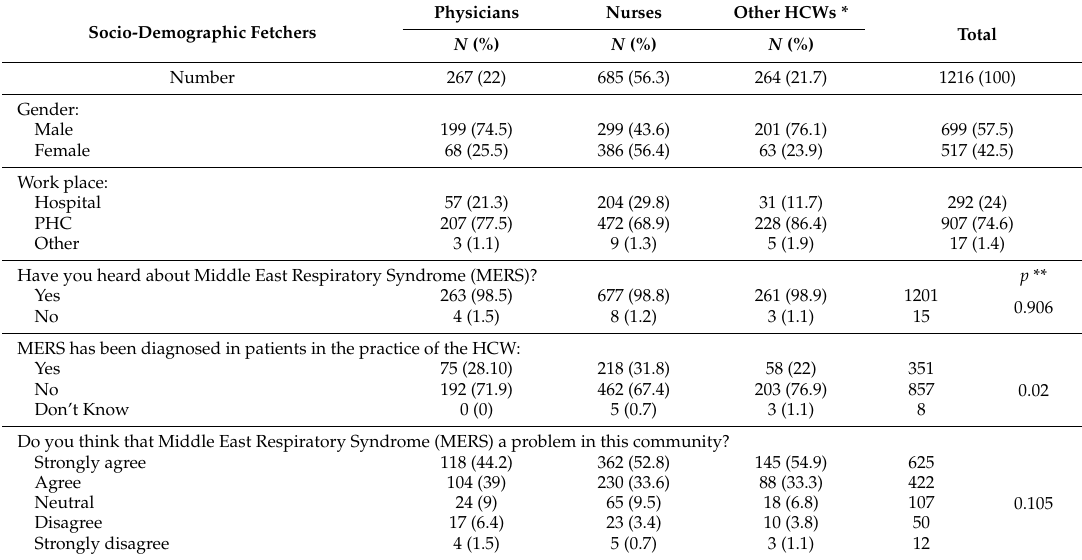
Table 1. Socio-demographic characteristics of participants and their awareness about Middle East Respiratory Syndrome Coronavirus